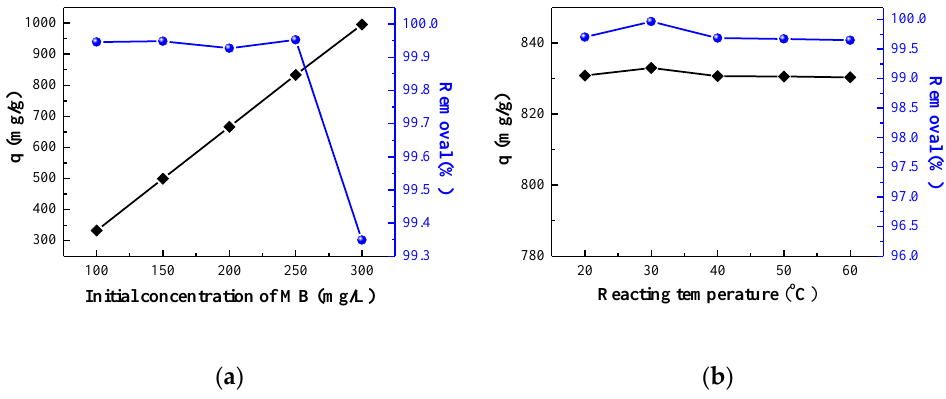
Figure 4. Effect of ( a ) initial concentration of MB solution and ( b ) reaction temperature, on adsorption capacity.